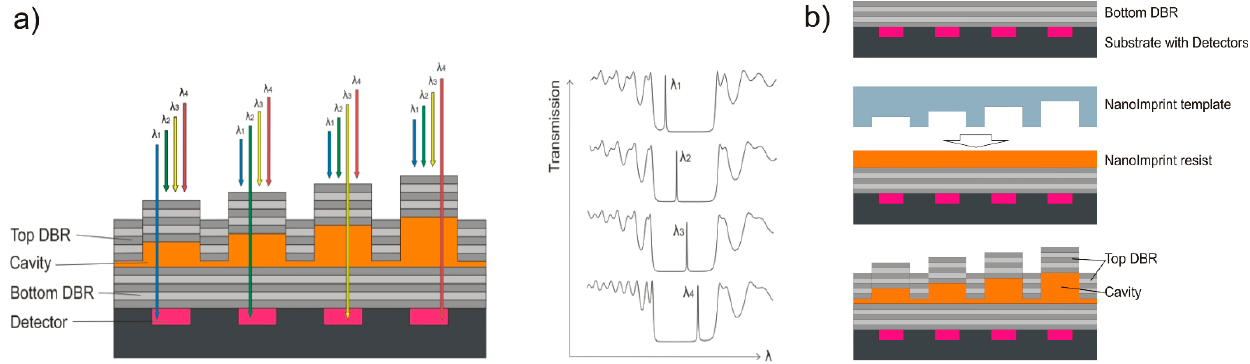
Figure 4. ( a ) Cross section Fabry–Pérot (FP) filter array with a detector array below constituting a nanospectrometer ( left ) and the related calculated transmission spectra ( right ); ( b ) The fabrication process uses Substrate Conformal Imprint Lithography (SCIL). Reprinted with permission from ref. [11]. Copyright 2021 MDPI.